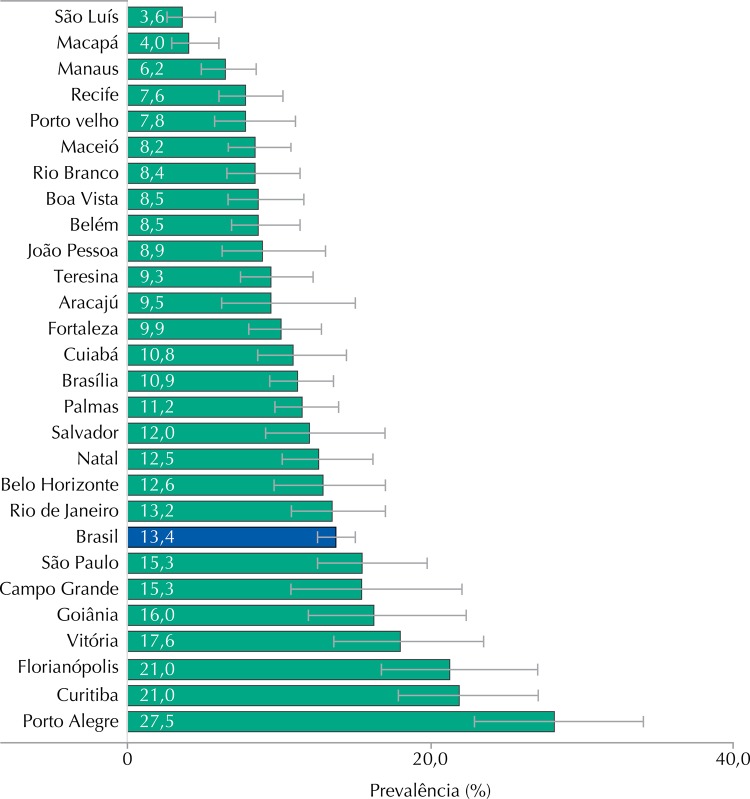
Prevalência de uso de pílula anticoncepcional oral na última relação sexual, segundo as capitais. ERICA, Brasil, 2013-2014.